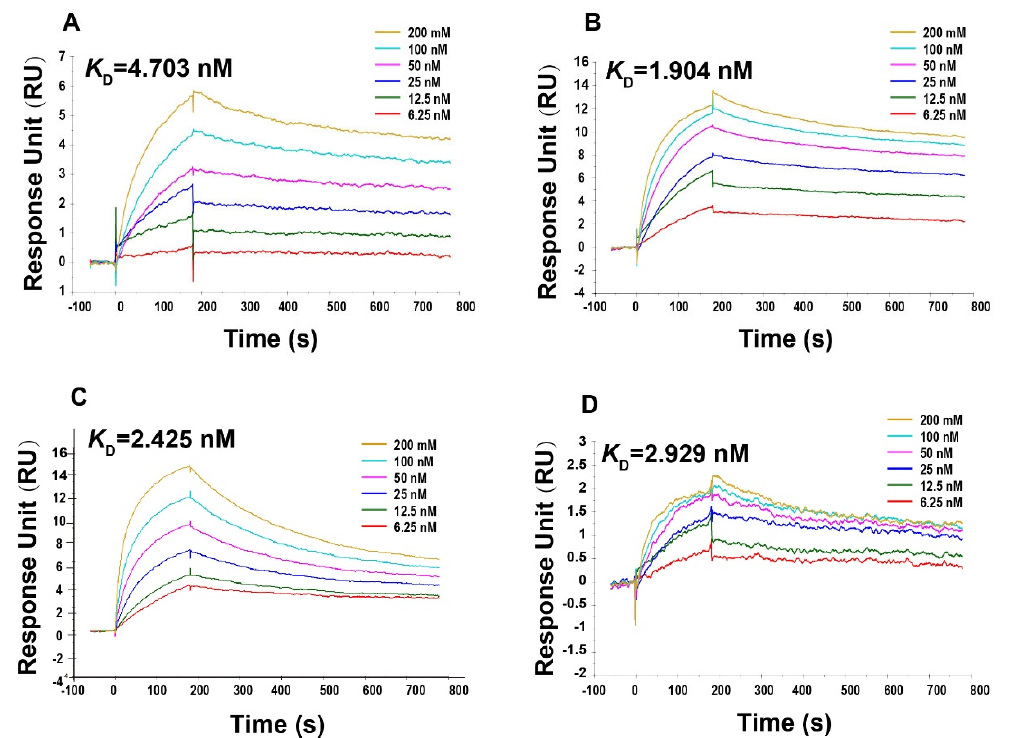
Figure 6. Surface plasmon resonance (SPR) analysis graphs of different inactivated virus samples to SARS-CoV-2 Spike chimeric monoclonal antibody D002. ( A ) Formaldehyde-inactivated. ( B ) Formaldehyde + BPL-inactivated. ( C ) BPL-inactivated. ( D ) BPL + BPL ‐ inactivated.